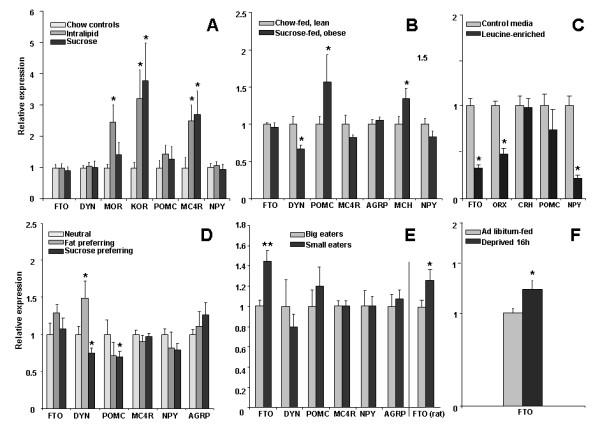
Relative expression of FTO and feeding-related genes in the hypothalamus of mice. A. Mice were exposed for 48 h to palatable Intralipid or sucrose solutions in addition to chow (n = 8/group). B. Mice differed in body weight by ca. 2.6 g. Increased body weight was induced by 3-week exposure to the sucrose solution given in addition to chow (n = 8/group). C. Organotypic cultures of the hypothalamus were treated for 48 h with anorexigenic leucine versus untreated controls (n = 7/group). D. Mice differed in 5-day preference for fat (Intralipid) vs. sucrose (n = 7 per preference-based group). E. Mice differed in their propensity to ingest more calories during exposure to palatable diets ("big eaters", vs. "small eaters"; n = 11 and 10, respectively). A similar rat model was used as control of FTO expression in another species (FTO rat). F. Mice were deprived of food for 16 h preceding decapitation (n = 8/group). AGRP, Agouti-related protein; DYN, dynorphin; MC4R, melanocortin receptor-4; NPY, neuropeptide Y; ORX, orexin; POMC, proopiomelanocortin; KOR, kappa opioid receptor; MOR mu receptor; MCH, melanin concentrating hormone. * - P < 0.05; ** - P < 0.01.